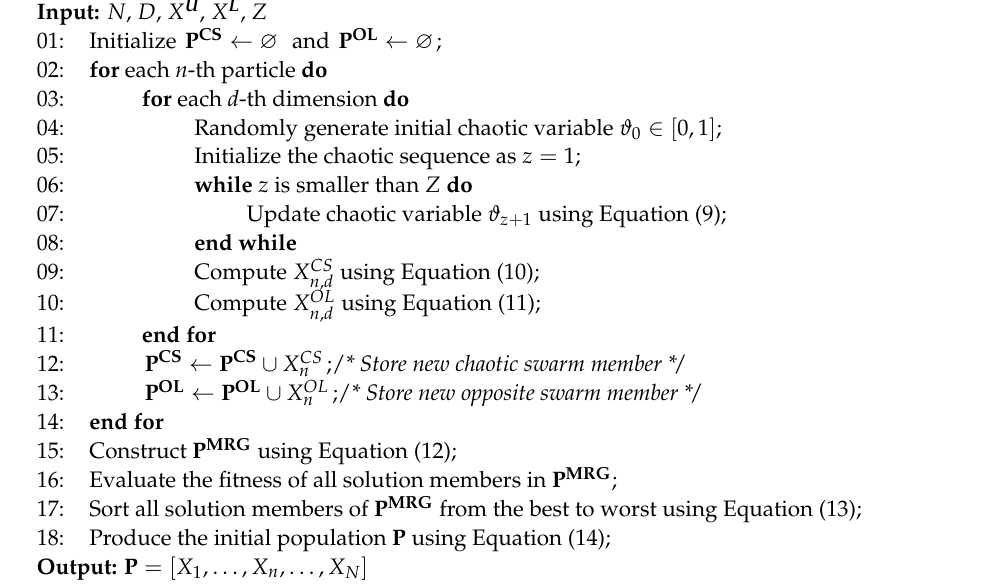
Algorithm 1. Pseudocode of CSOBL initialization scheme for